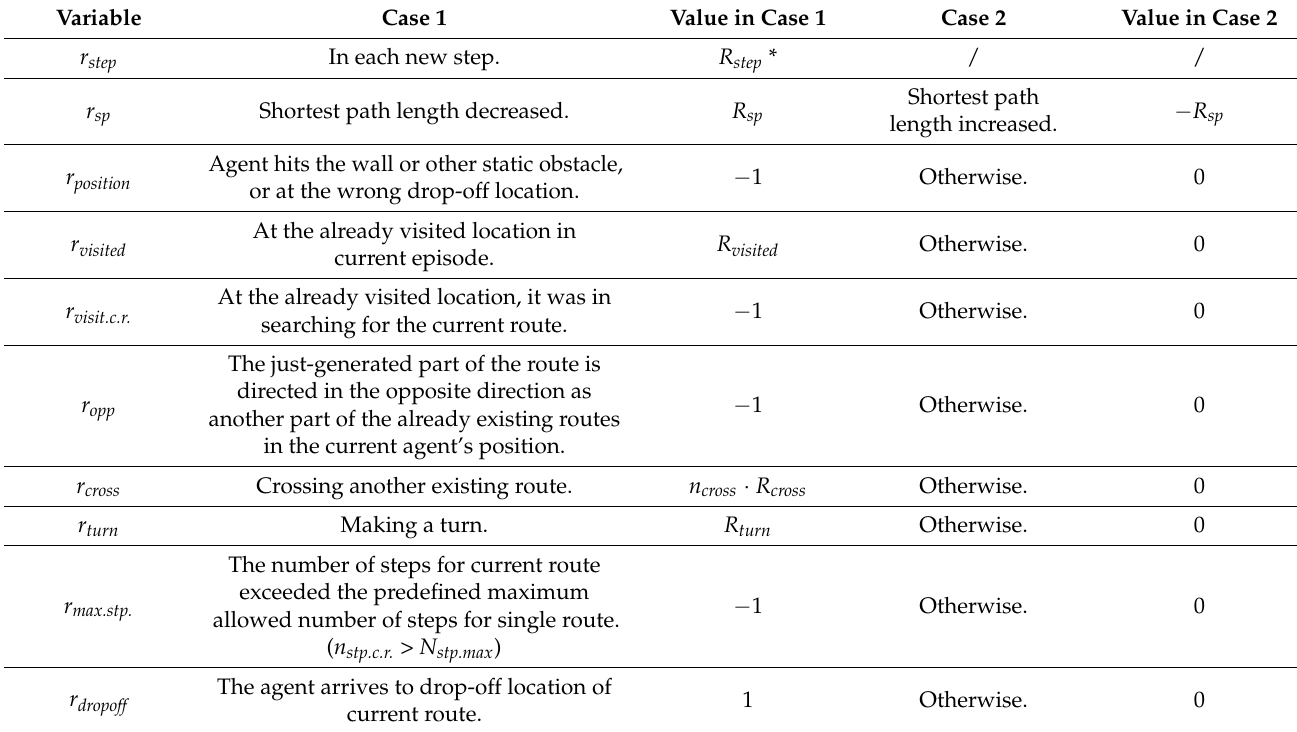
Table 2. Values for the individual parts of the reward function.